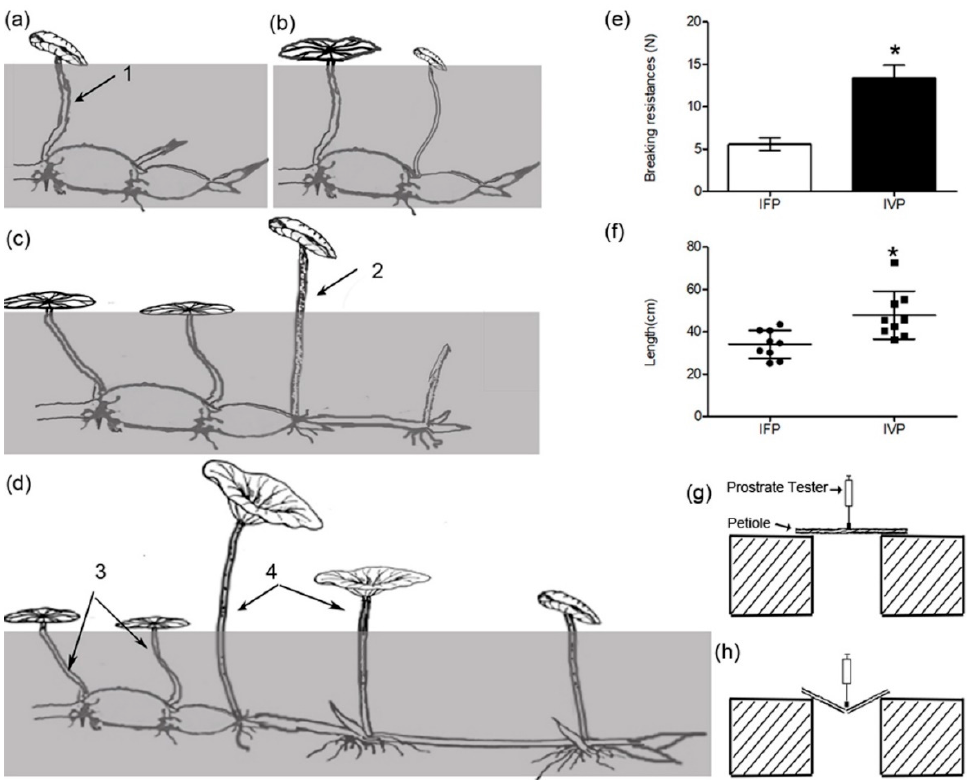
Figure 1. Schematic diagram of growing processes of floating leaf and vertical leaf. ( a – d ) stand different growth stages of leaves. Arrow 1 indicates initial floating leaves’ petiole (IFP), arrow 2 indicates initial vertical leaves’ petiole (IVP), arrow 3 indicates mature floating leaves’ petiole (MFP) and arrow 4 indicates mature vertical leaves’ petiole (MVP), respectively; ( e ) measurements of breaking resistances in two type petioles were performed using a prostrate tester; ( g , h ) show status of petioles before and after putting pressure on it; ( f ) shows the length of petioles which were cultured in pot with 20 cm depth water. Data are means ± SD from 9 independent petioles (IFP and IVP). Asterisks indicate significant changes according to Student’s t-test (* p < 0.05).